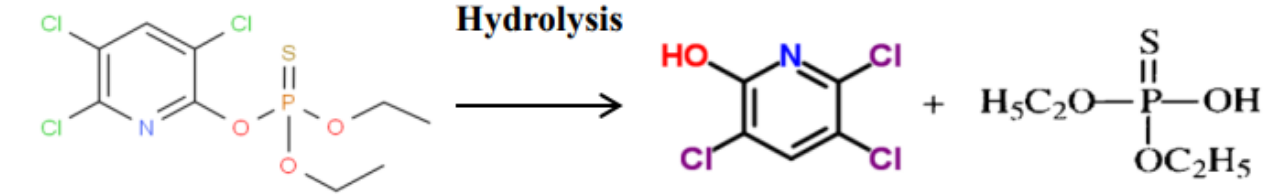
Figure 5. Hydrolyzed metabolic pathway of chlorpyrifos in wheat samples.